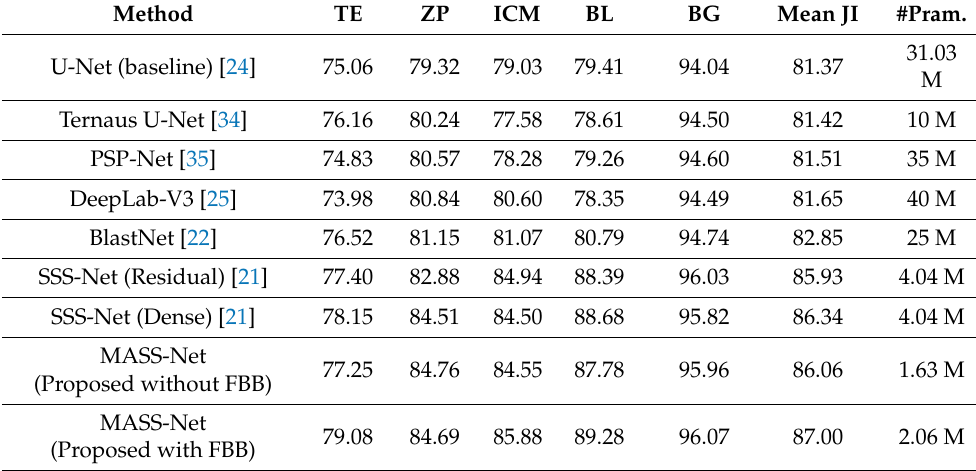
Table 3. Performance comparison of proposed MASS-Net with current state-of-the-art methods for blastocyst component segmentation. (#Pram. show the number of trainable